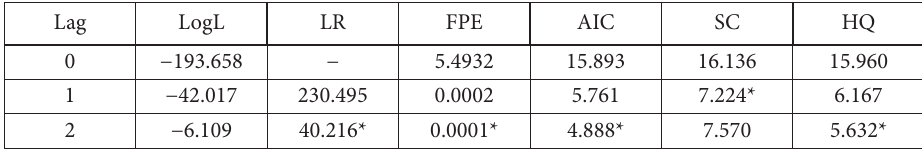
Table 2. Lag length selection criteria for cointegration